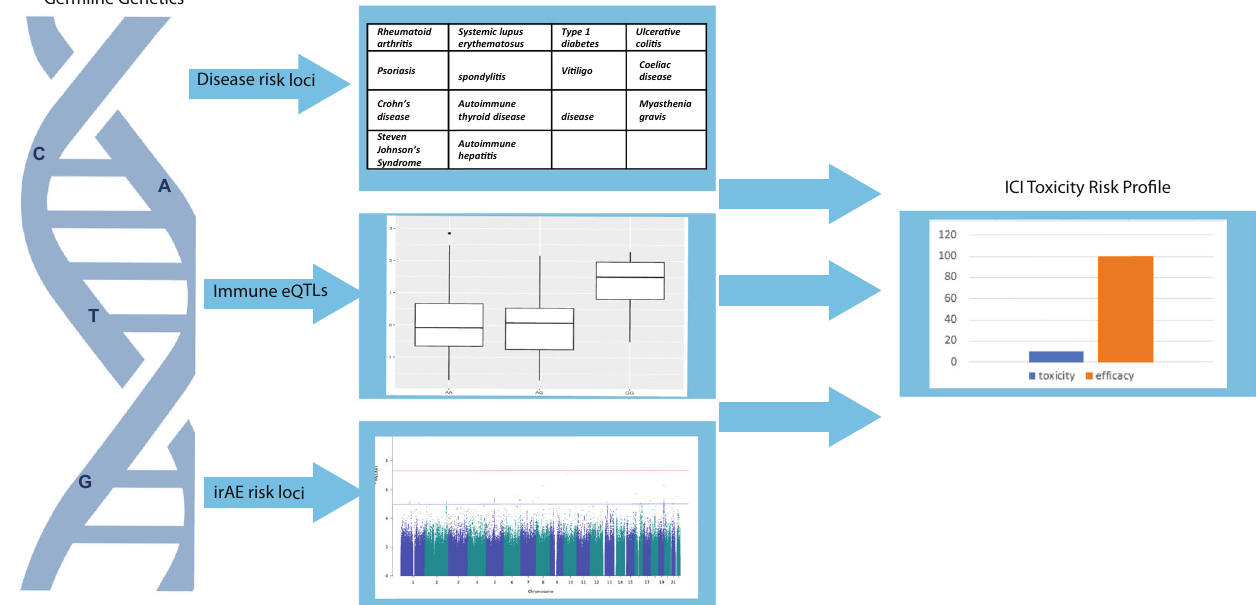
Fig. 1 Germline genetic pro fi ling may assist in generating patient ICI induced toxicity pro fi les. An ICI toxicity risk pro fi le incorporating germline genetic factors linked with autoimmune disease risk loci, immuno-modulatory eQTLs and irAE associated loci would aid in toxicity management and decision-making to maximise treatment bene fi t while reducing the risk of serious